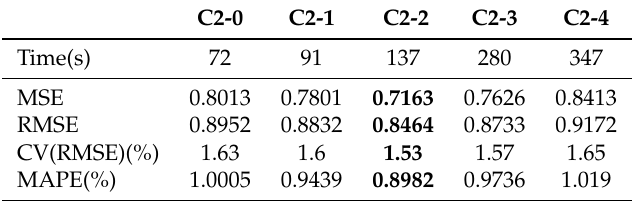
Table 3. Summary of accuracy metrics for RNN LSTM model forecasting: Chicago 2.